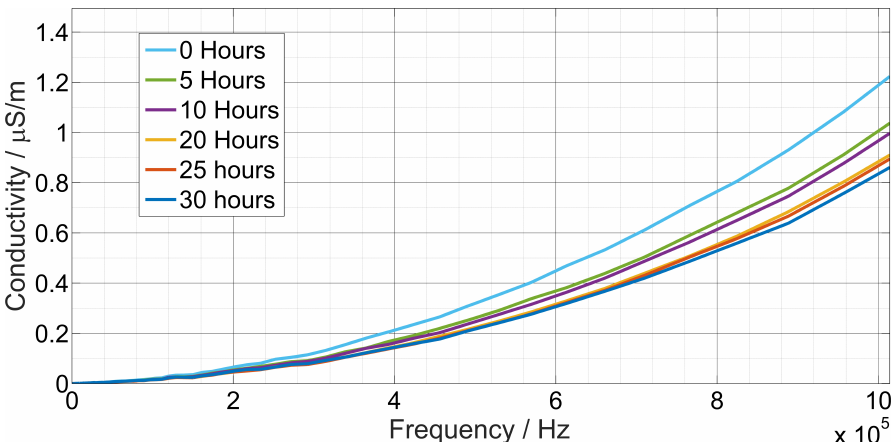
Figure 5. The measured conductivity function of heating time and frequency for sunflower oil.